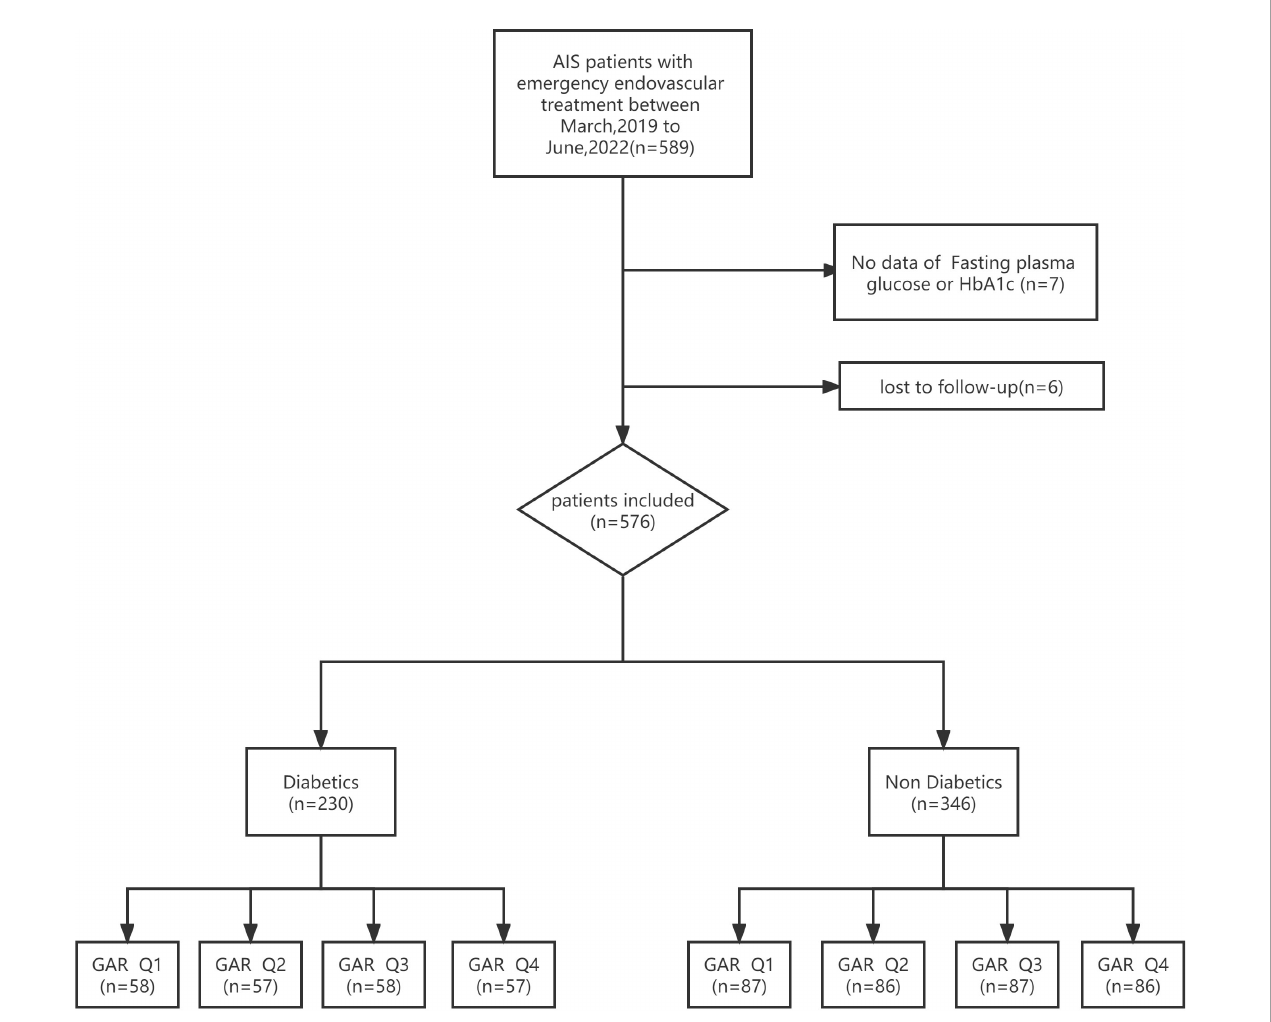
FIGURE1 Flowchart of study participants. AFIS, acute ischemic stroke; HbA1c, glycated hemoglobin; GAR Q1, first glucose-to-glycated hemoglobin ratio quartiles; GAR Q2, second glucose-to-glycated hemoglobin ratio quartiles; GAR Q3, third glucose-to-glycated hemoglobin ratio quartiles; GAR Q4, fourth glucose-to-glycated hemoglobin ratio